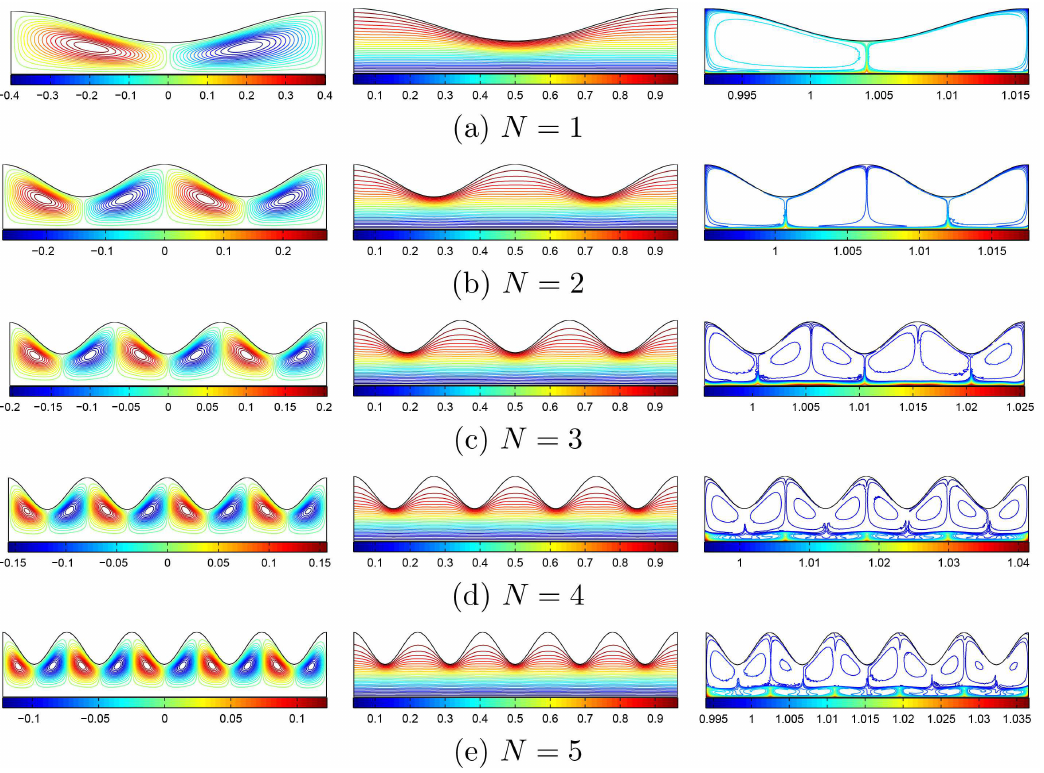
Figure 6. Variation of the streamlines ( left ), isotherms ( middle ), and nanoparticle distribution ( right ) evolution by number of oscillations ( N ) for A = 0.1, Ra = 10 6 and φ = 0.02 in the plane ( X , Y